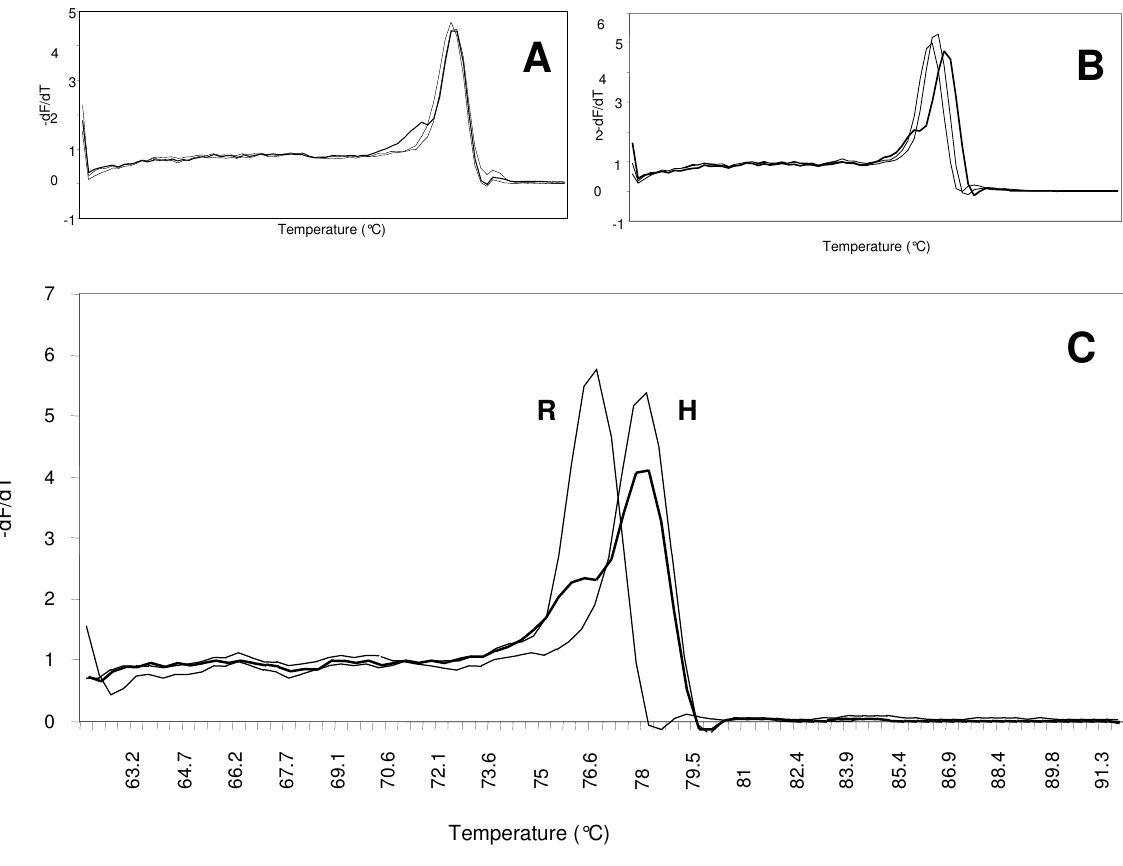
DMSO. Panel B: Melting profile with DMSO 5%. Panel C: Melting profile with DMSO 10%. Heterozygotes are depicted as thick lines, the heterozygous pattern is distinguishable from the two homozygous curves because of the shoulder, most likely due to the presence of